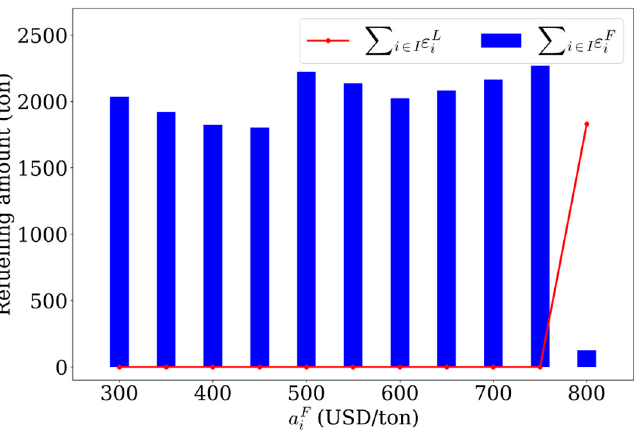
Figure 1. Comparison of ∑ i ∈ I ε F